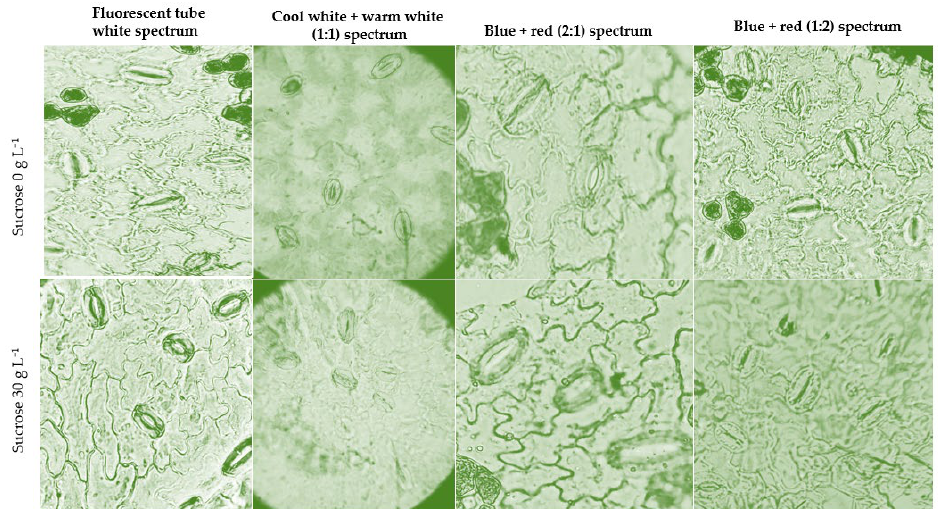
Figure 5. Light microscopic observations (40 × magnification) of the leaf stomata of in vitro blackberry plantlets according to light spectra and sucrose concentration